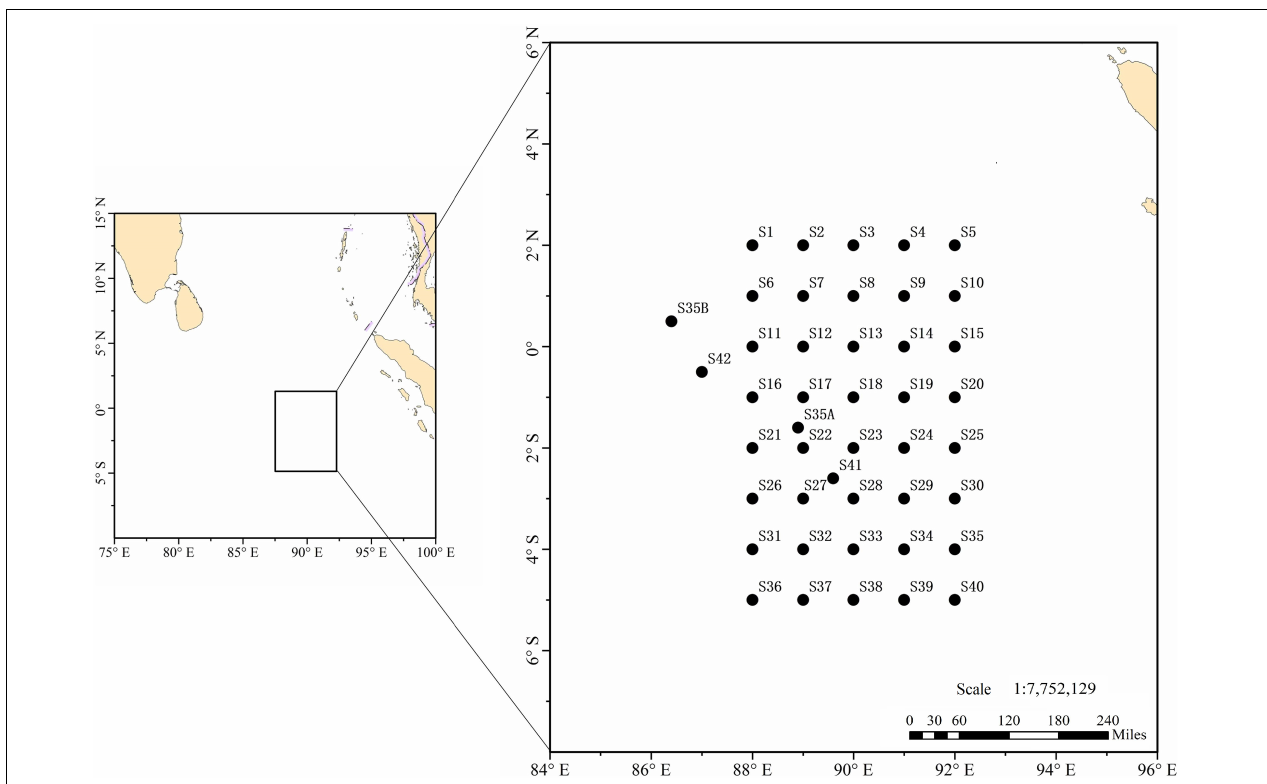
FIGURE 1 | Survey area (Ninety East Ridge) and ichthyoplankton survey stations.